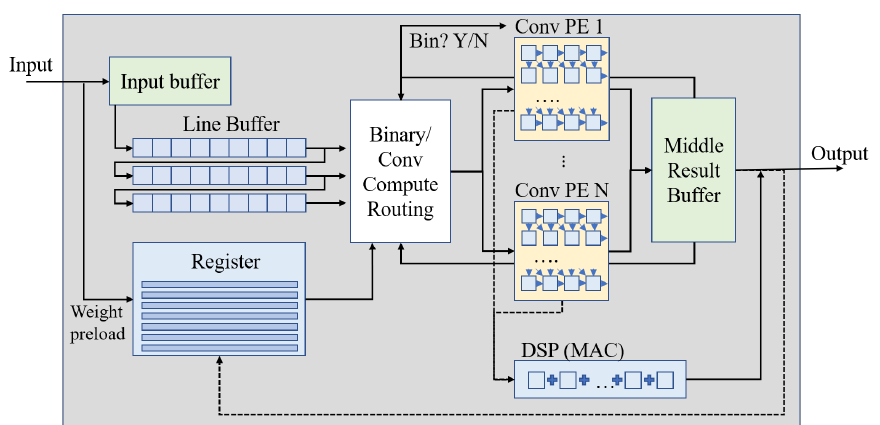
Figure 3. Overall hardware architecture of the